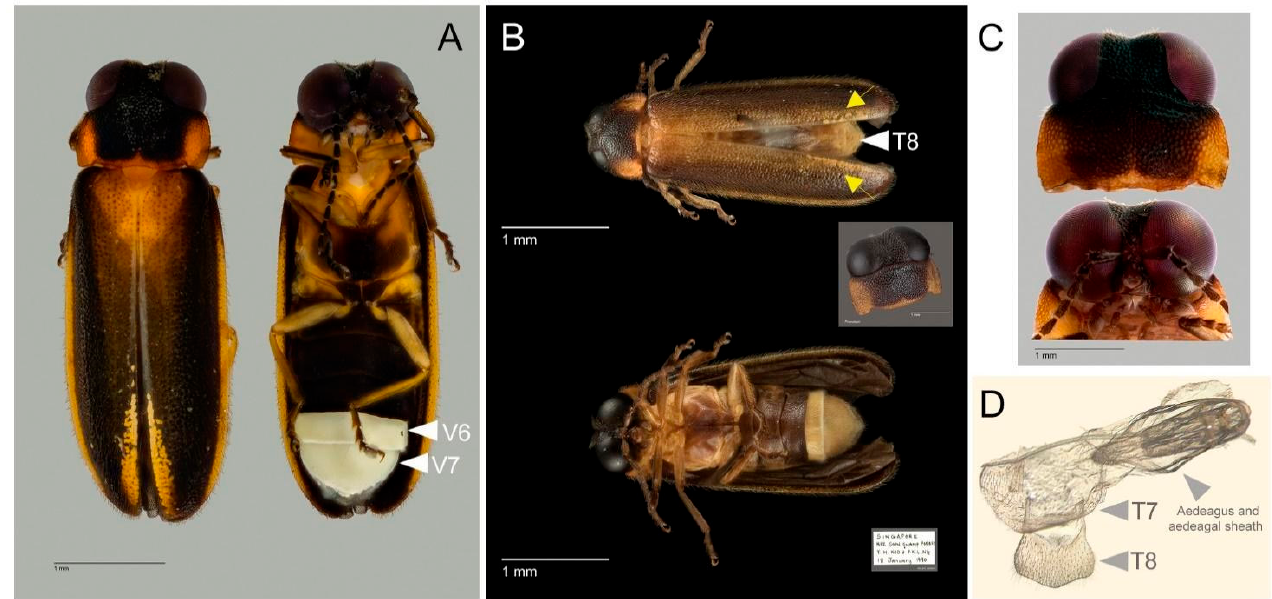
Figure 4. Males of Luciola singapura sp. nov. Habitus ( A , B ), head and pronotum ( C ); Tergite 8 after dissection ( D ). ( A ). Holotype male, from recent collection preserved in ethanol, light organ (LO) located on ventrite 6 (V6) and ventrite 7 (V7), presence of fat body along apex of suture, arrowed; ( B ). Habitus of paratype male. Coloration of paratype male collected 30 years ago preserved as dry specimen, arrow indicated presence of fat body along suture, tergite 8 (T8) from dorsal view and pronotum (inset); ( C ). Top: Head and pronotum of paratype male, below: Mouthpart and some parts of antenna; ( D ). Dissection parts of holotype male: tergites 7-8 indicated with aedeagus and aedeagal